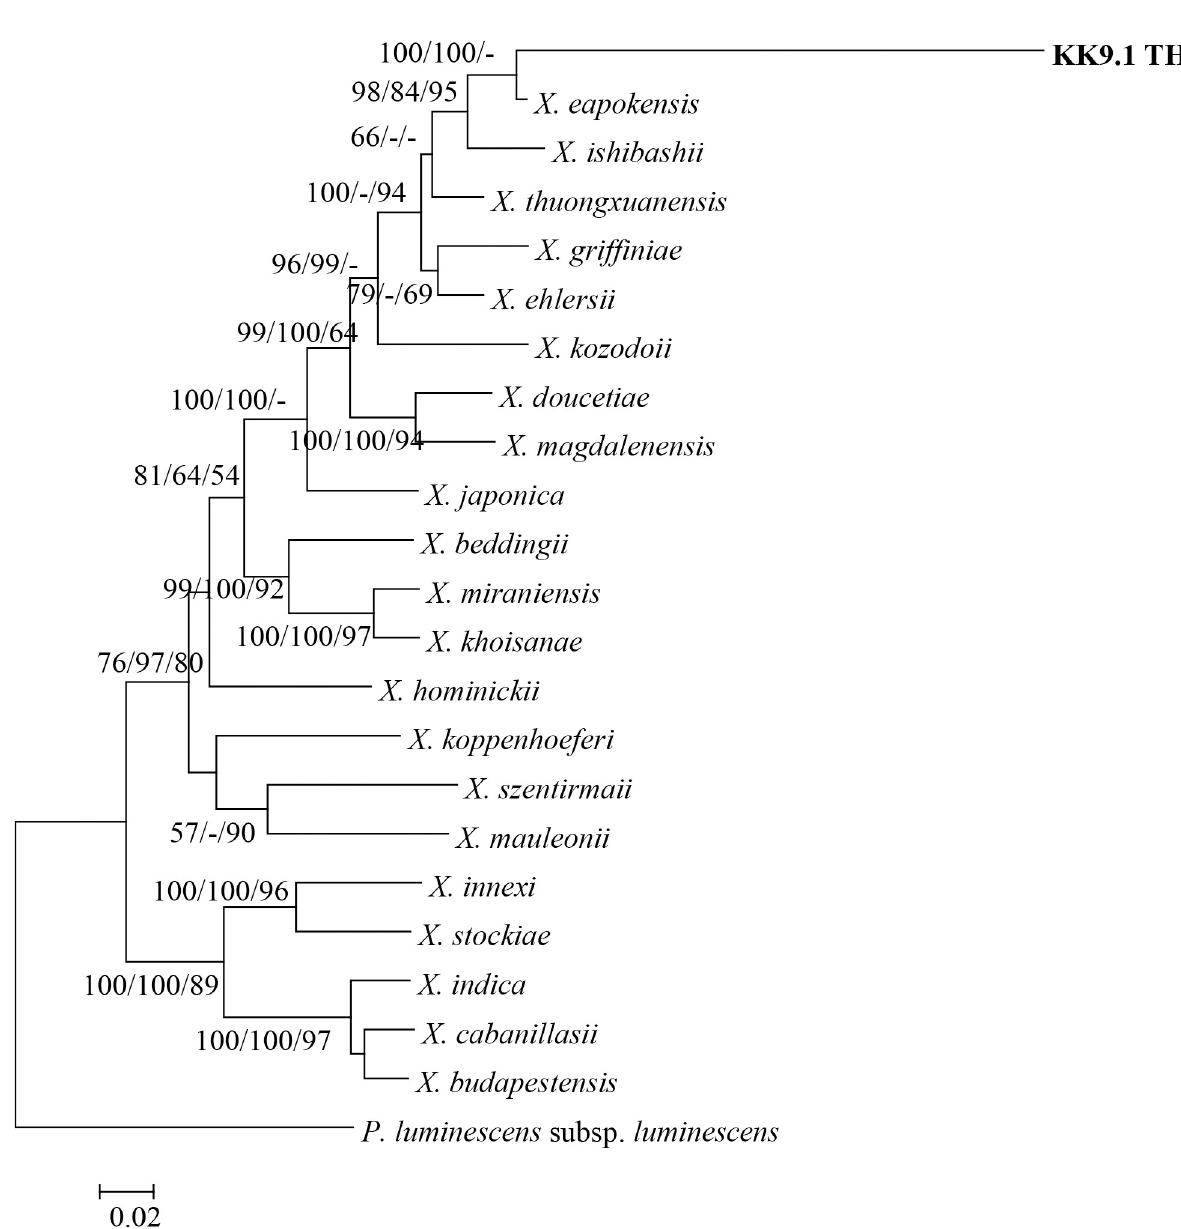
Fig 2. Maximum likelihood tree of concatenated sequences of Xenorhabdus sp. (KK9.1_TH) (shown in bold letter) based on truncated recA (588 bp), gyrB (846 bp), dnaN (828 bp), gltX (1,057 bp), and infB (1,052 bp) compared with the sequences of Xenorhabdus strains from GenBank. P . luminescens subsp. luminescens is included as an out-group. Bootstrap values are reported out of 1000 replicates. The numbers shown above the branches are support values of Maximum likelihood/Neighbor-joining/Bayesian posterior probabilities for clades supported above the 50% level. The bar indicates 2% sequence